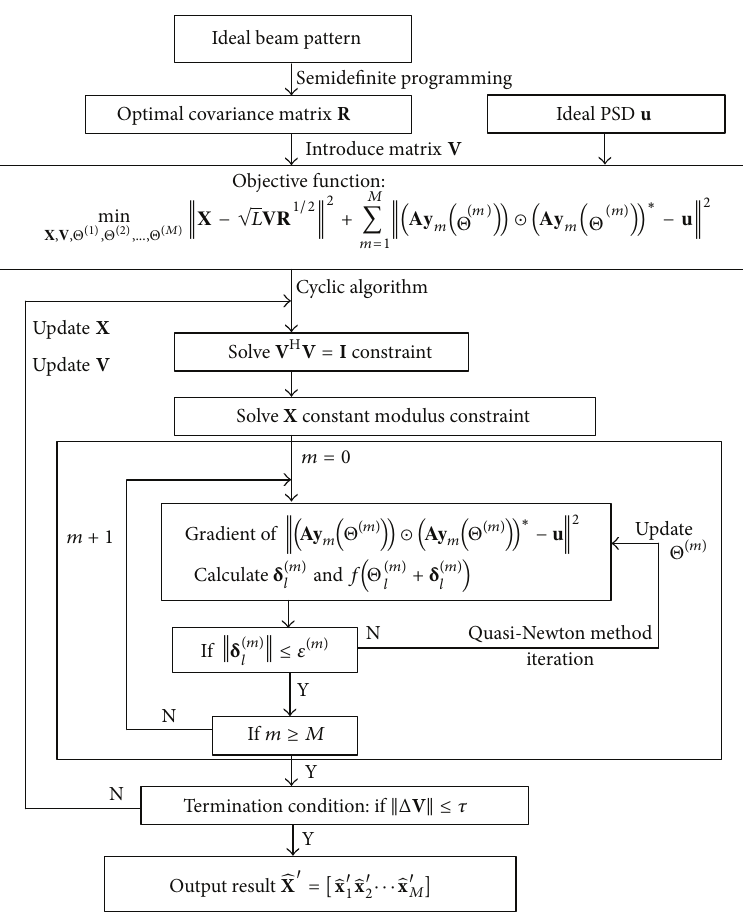
Figure 2: Flow of MIMO beam pattern and sparse frequency radar waveforms optimization